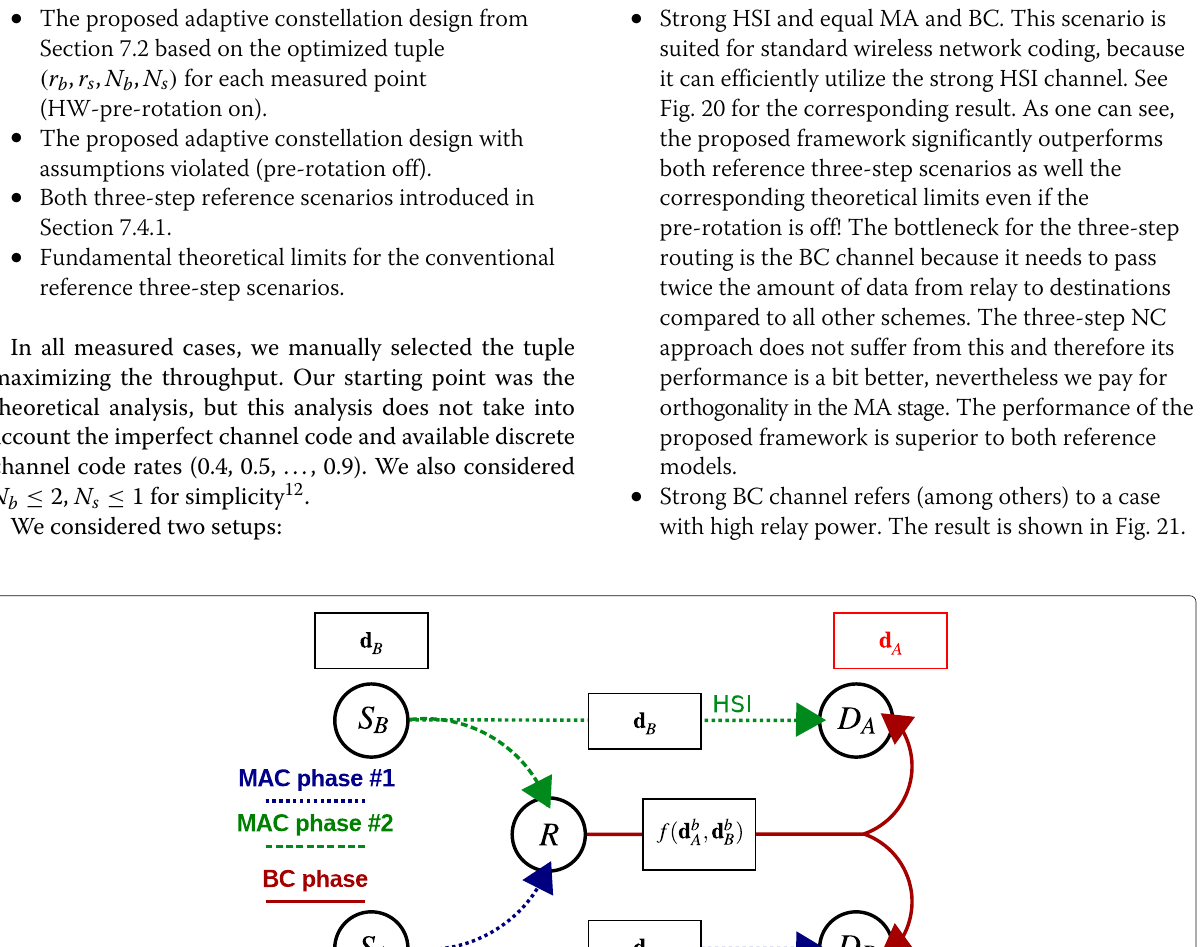
Fig. 18 Three-step reference scenario with conventional network coding